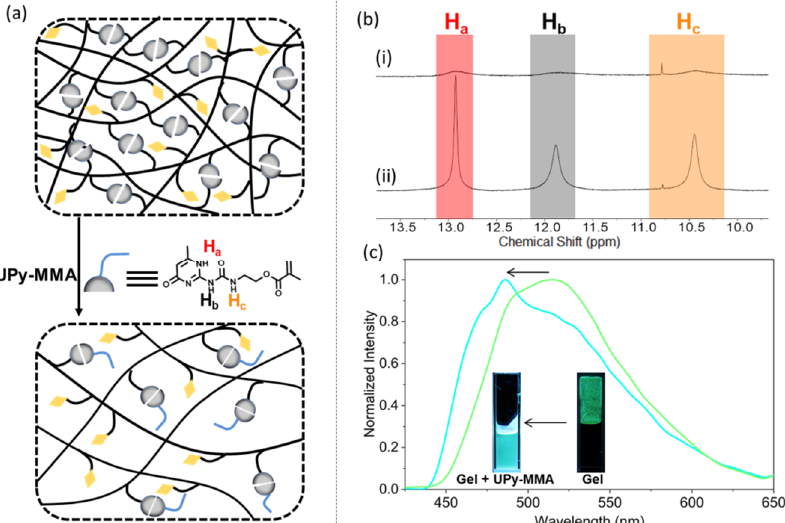
Figure 6. ( a ) Schematic diagram of the depolymerization process of supramolecular polymers networks when UPy-MMA was added; ( b ) The comparison of partial 1 H NMR spectra (400 MHz, CDCl 3 , 298 K) of (i) PPMU (100 mg/mL) (ii) PPMU (100 mg/mL) added with UPy-MMA ( PPMU and UPy-MMA ’s final concentrations were 100 mg/mL and 35 mg/mL, respectively); ( c ) Normalized fluorescent spectra of PPMU (100 mg/mL) and PPMU added with UPy-MMA ( PPMU and UPy-MMA ’s final concentrations were 100 mg/mL and 35 mg/mL, respectively) at 298 K in CHCl 3 . λ ex = 365 nm. Slit: 10/8 nm. Inset: Fluorescent photographs of PPMU in CHCl 3 before and after the addition of UPy-MMA recorded under a handheld UV lamp.